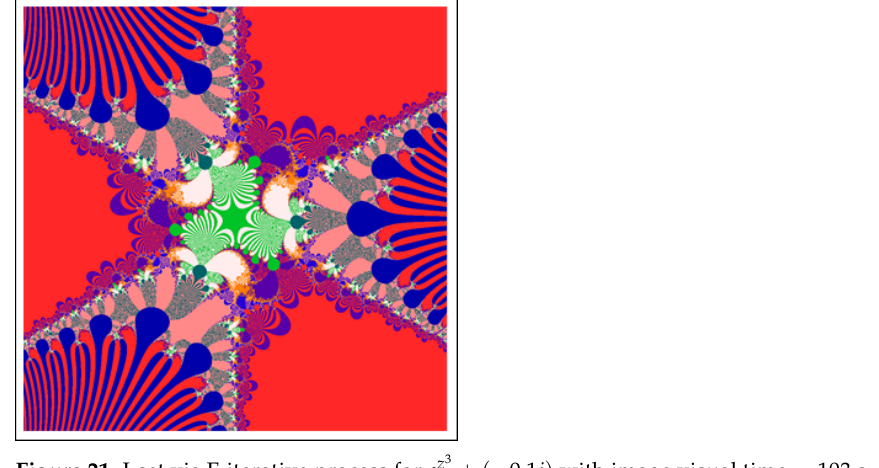
Figure 21. J-set via F-iterative process for e z 3 + ( − 0.1 i ) with image visual time = 103 s.